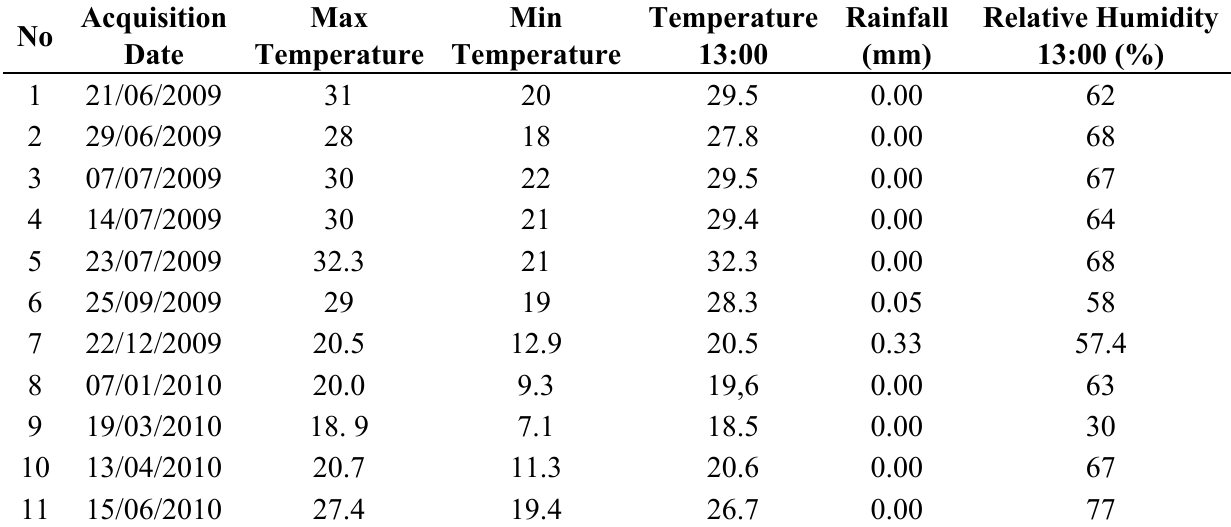
Table 2. Meteorological data from the Paphos airport (Data provided from Meteorological Service of